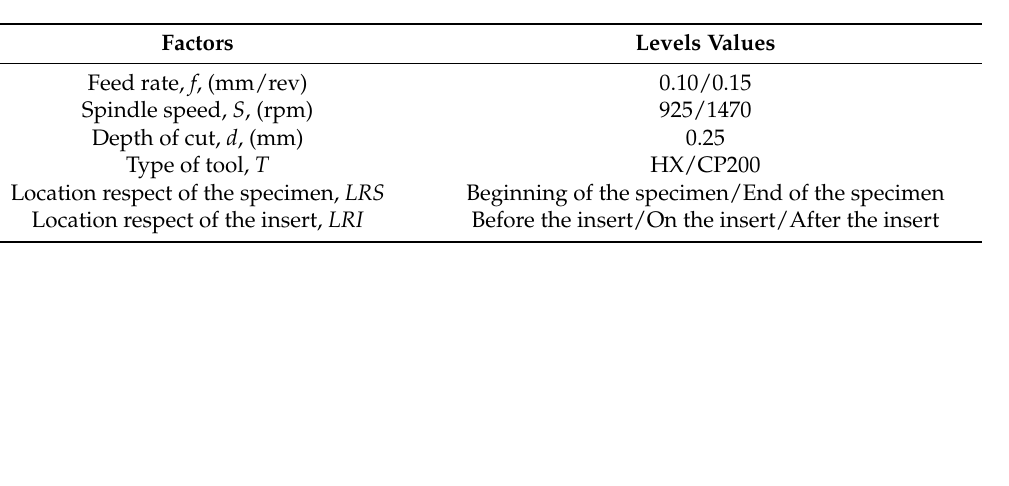
Table 4. Selected values for the levels of each factor